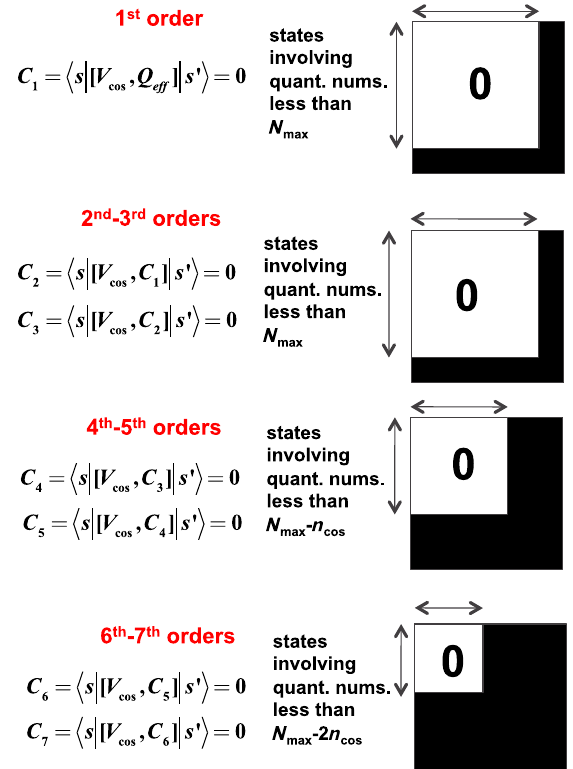
FIG. 12. Hereweshowat c ¼ ∞ howthematrixelementszeroed out for the commutator C 1 remain zero for the higher order commutators C n> 1 . In the top block we graphically display how the matrix elements of C 1 are zeroed out for states with quantum numbers less than N max . In the second block, we show that the matrix elements of the second and third order commutators C 2 and C 3 are also zero for this same set of states. It is only for the fourth and fifth order commutators, C 4 and C 5 , that the set of states with zero matrix elements begins to shrink to states with quantum numbers less than N max − n cos (as pictured in the third block). The set of states with zero matrix elements on C 6 and C 7 shrinks further to states with quantum numbers less than N max − 2 n cos . This shrinkage in the set of states by steps of n cos continues at higher order, one step for every two orders of